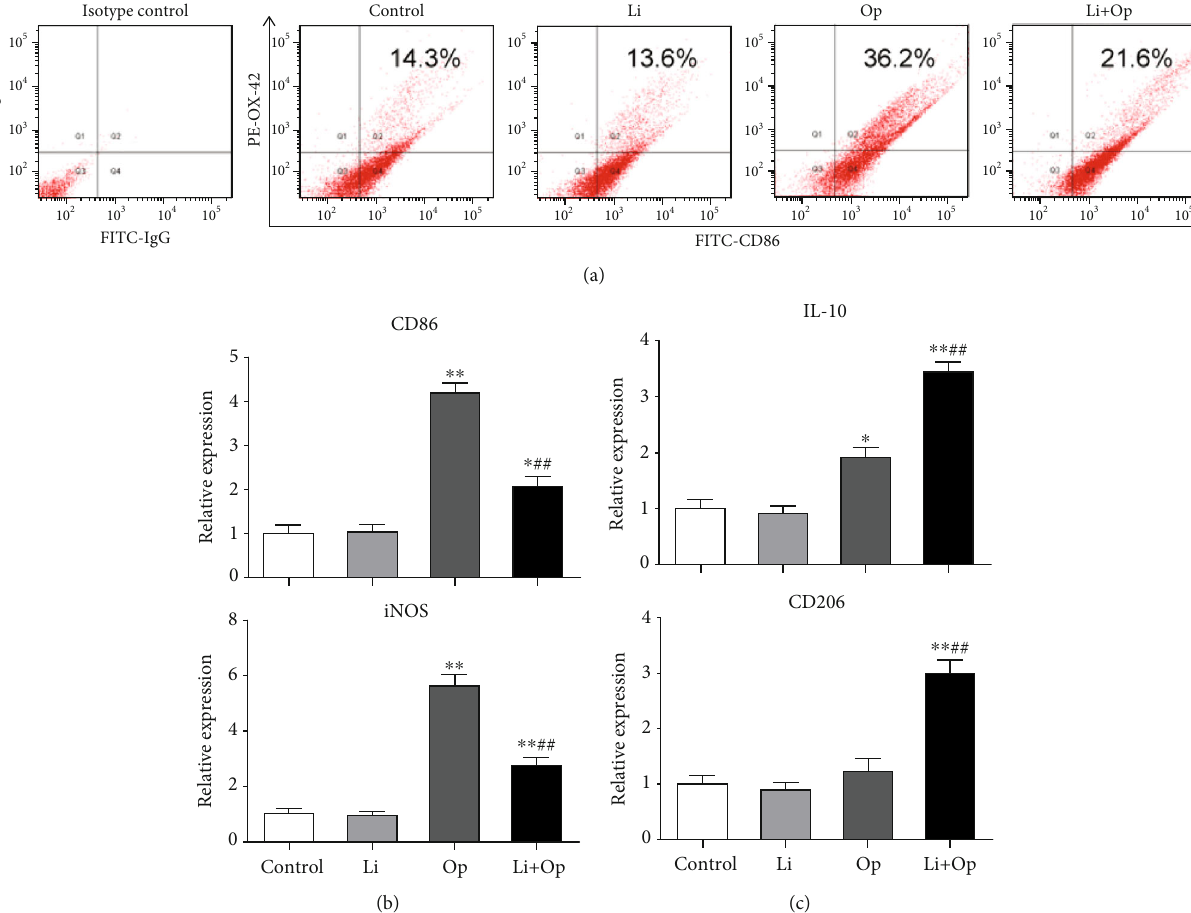
Figure 4: E ff ects of GSK-3 β inhibition on the expression of M1 and M2 markers in microglia. (a) Flow cytometry analysis was used to determine the CD86 expression in hippocampal microglia. (b, c) Expression of M1 (CD86 and iNOS) and M2 (IL-10 and CD206) markers in the hippocampus was examined using quantitative RT-PCR. The data are presented as means ± s : e : m : ( n = 3 ). ∗ P < 0 : 05 and ∗∗ P < 0 : 01 compared with the control group. ## P < 0 : 01 compared with the OP